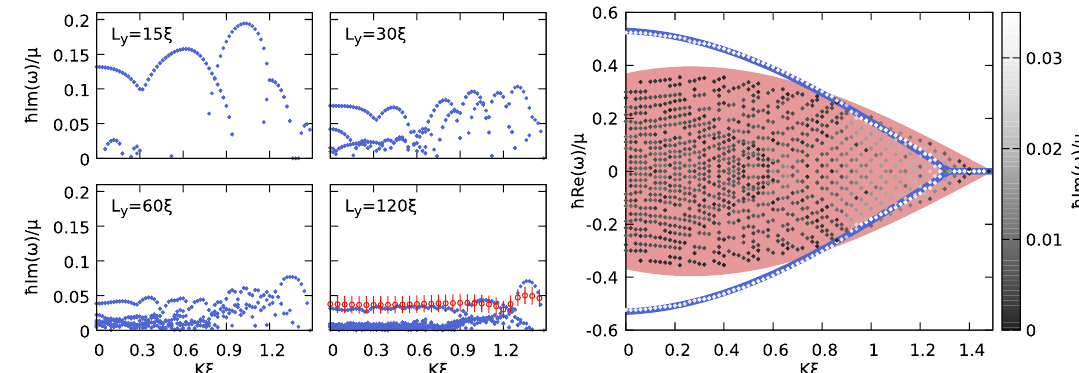
Figure 5: Left plots: instability rates of all the dynamically unstable modes for ∆ v = 3 c and four different values of the transverse system size. For L s we also show with red empty circles the instability rates extracted from the time- dependent calculations of Figure 6. The error bars are given by the finite evolution time of our simulations. Right plot: schematics of the spectrum of the infinite system, inferred from the distribution of the dynamically unstable modes of the L system, that are plotted with points. The colorscale of the points shows their insta- bility rate. The red filled area is where energetic instabilities associated to supersonic motion are expected in an infinite system. The blue line highlights the most unstable modes, responsible for the RI, that also remain unstable in the infinite system. In the surrounding white space only positive-energy modes are